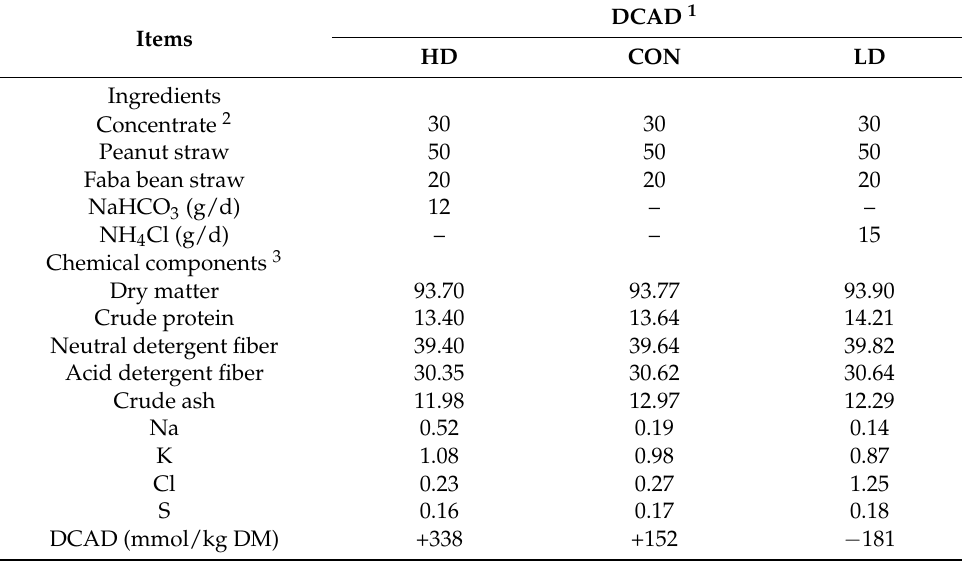
Table 1. Ingredients and chemical components of diet for goat (%, dry matter (DM)